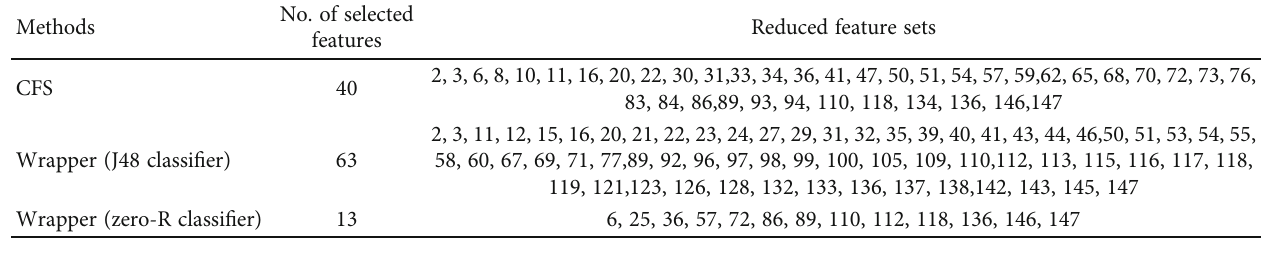
Table 2: Pro fi les of the selected features for di ff erent subset evaluation methods.